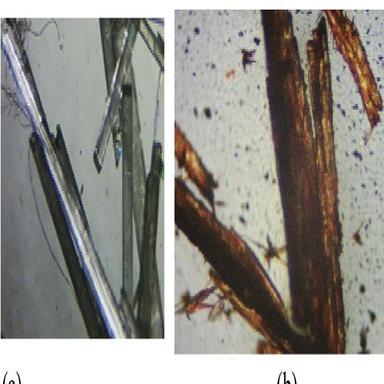
Microscope images of (a) TNT, (b) TNT-ATL.